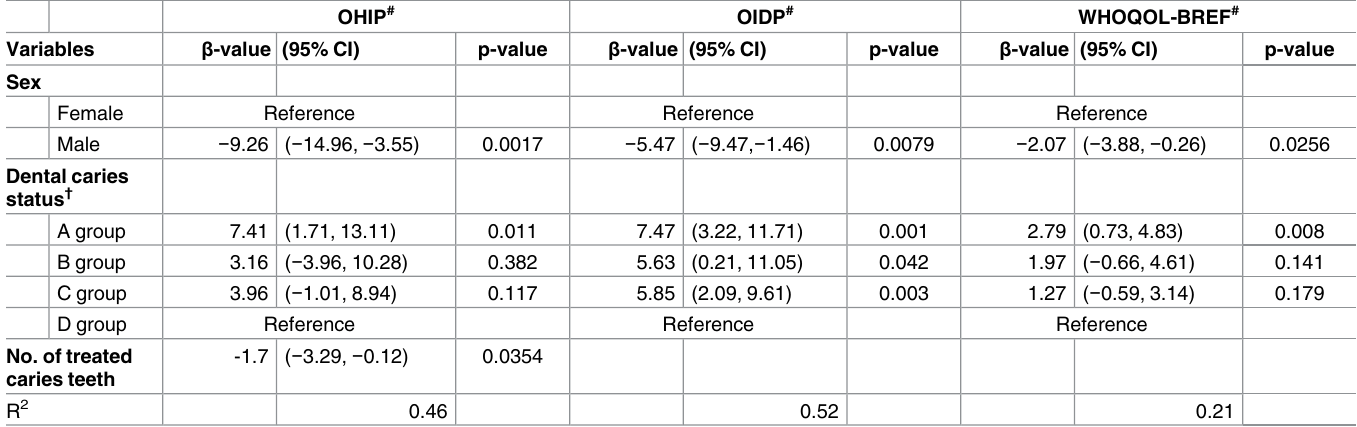
Table 5. The association with responsiveness of all measurements for patients with dental caries